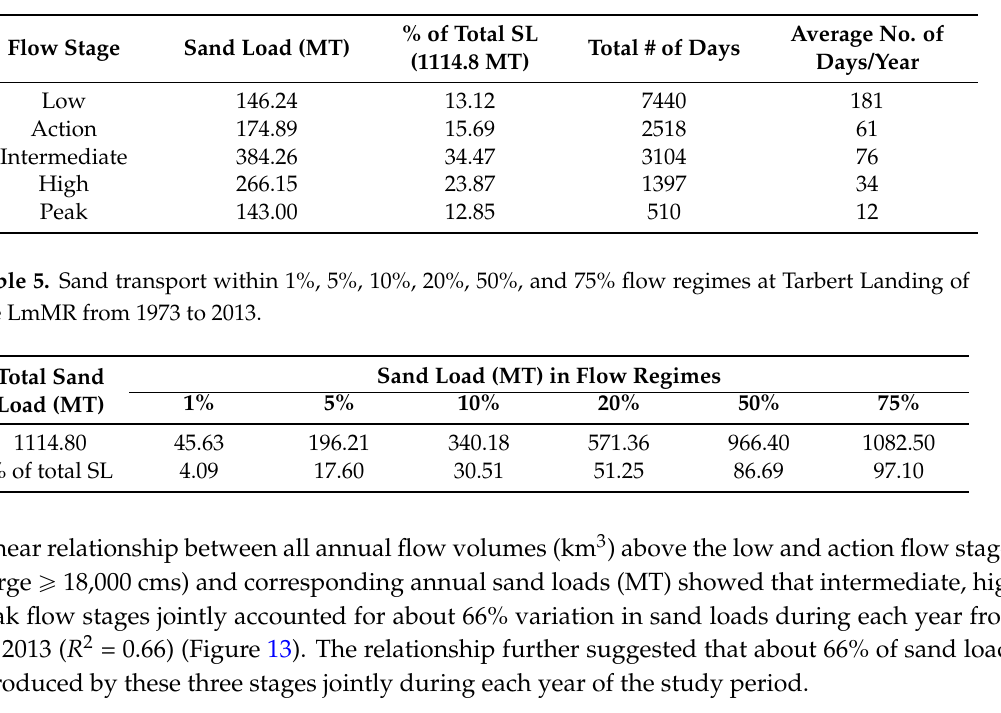
Table 5. Sand transport within 1%, 5%, 10%, 20%, 50%, and 75% flow regimes at Tarbert Landing of the LmMR from 1973 to 2013.